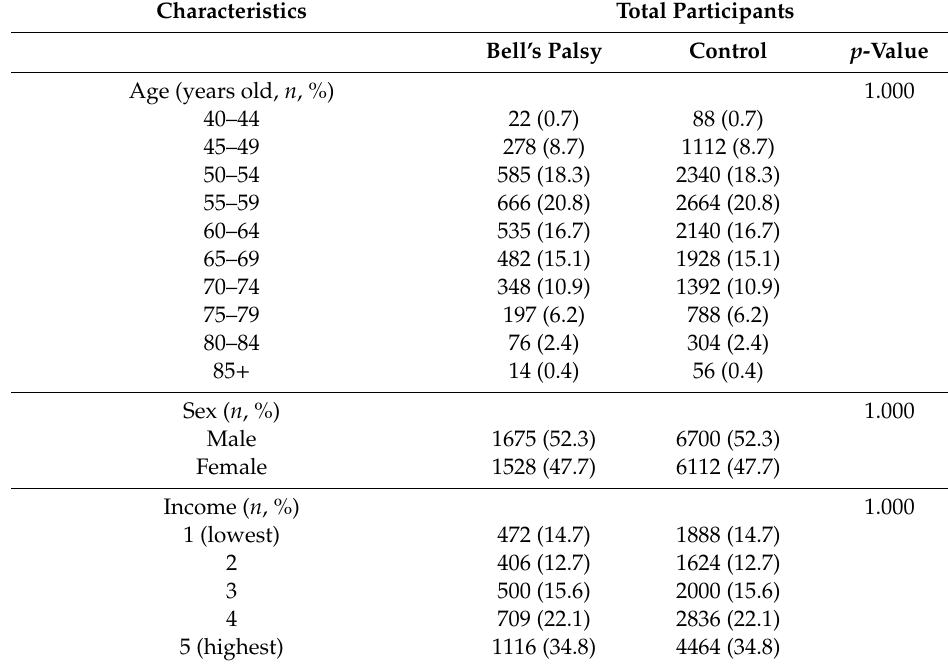
Table 1. General characteristics of